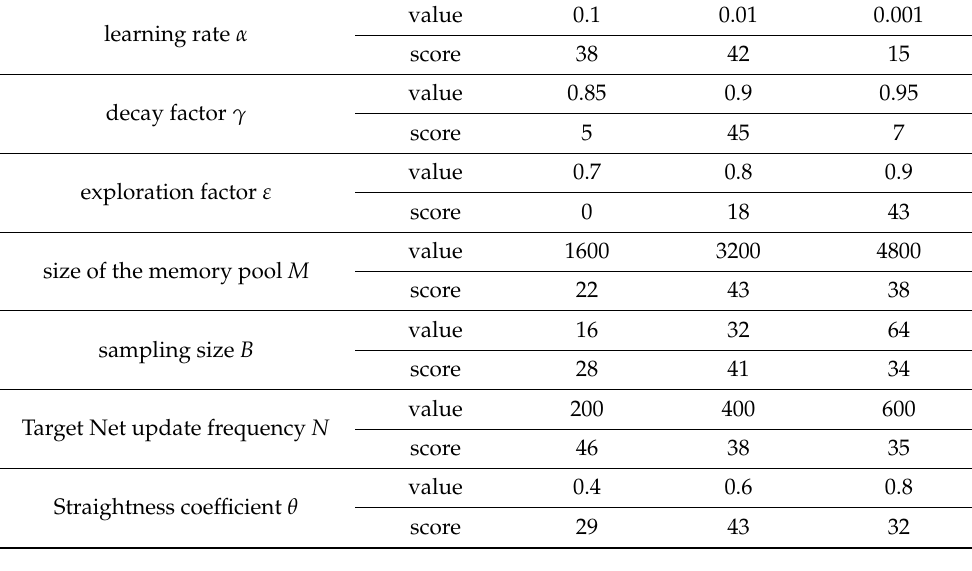
Table 2. Final parameter